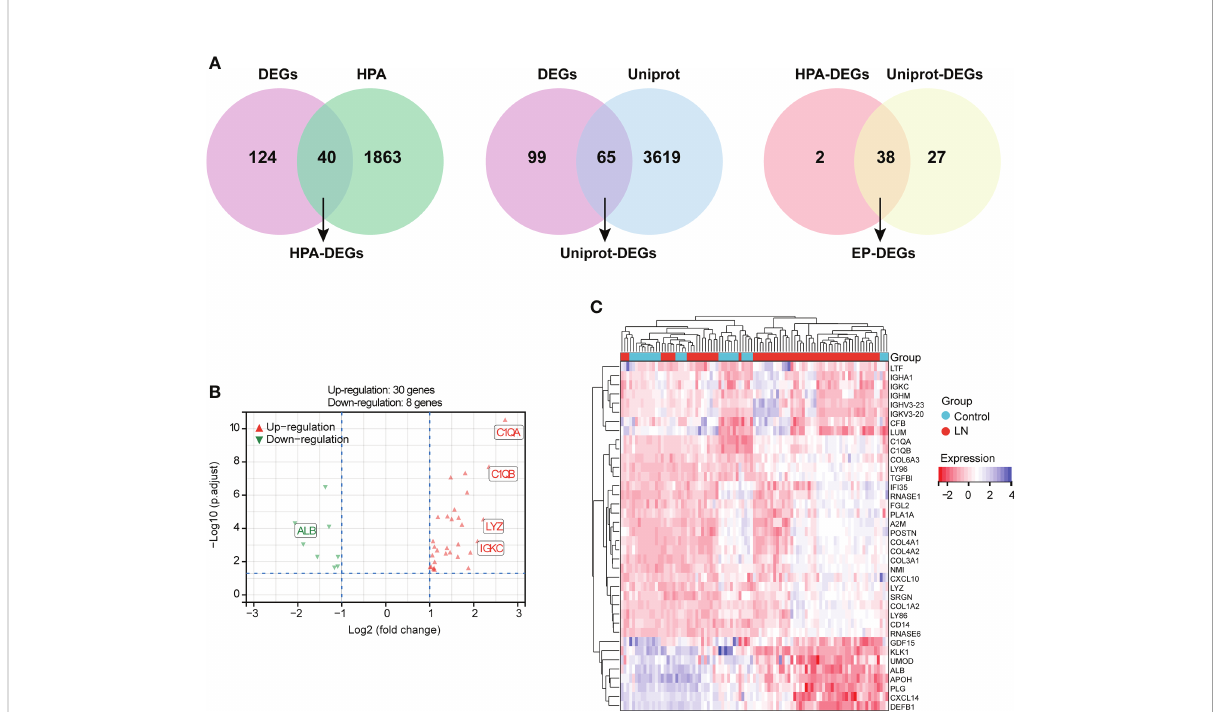
FIGURE 3 Identi fi cation of DEGs encoding extracellular proteins (EP-DEGs). (A) Venn diagram of 40 HPA-DEGs obtained based on the intersection between HPA database-extracellular proteins and LN-DEGs. Meanwhile, a Venn diagram of 65 UniProt-DEGs obtained based on the intersection between UniProt database-extracellular proteins and LN-DEGs. Finally, 38 EP-DEGs were screened out based on the intersection between HPA-DEGs and UniProt-DEGs. (B) Volcano plot of EP-DEGs between LN patients and controls. (C) Expression heatmap of screened EP-DEGs.